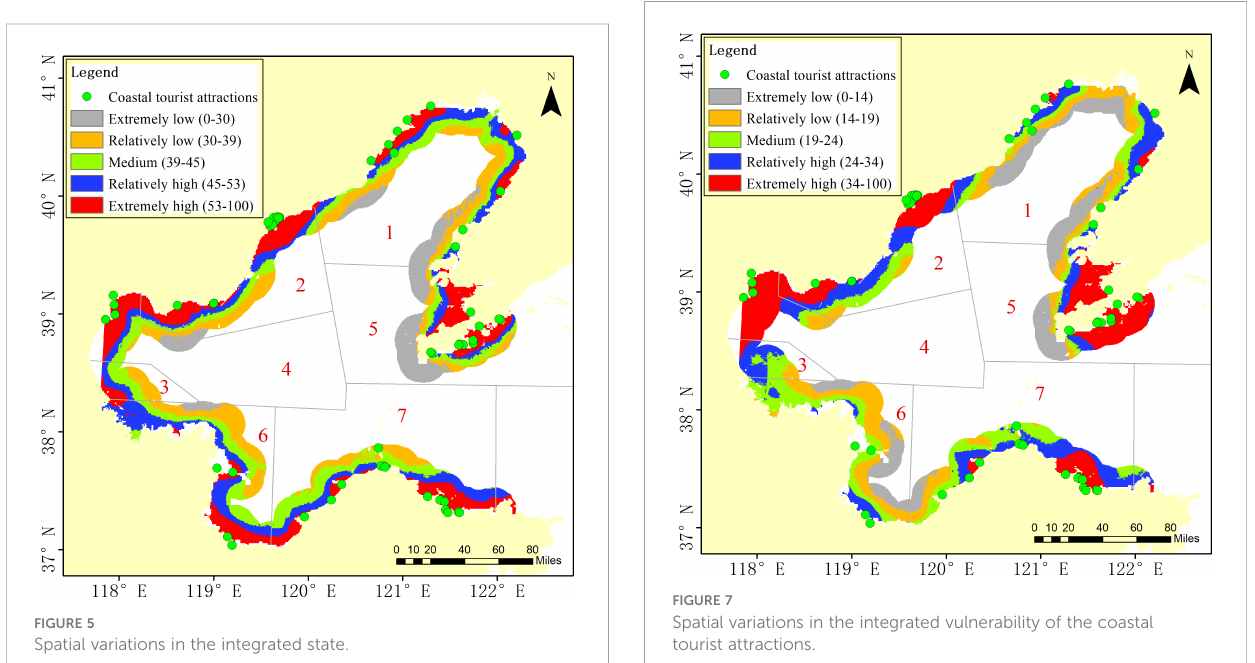
FIGURE 5 Spatial variations in the integrated state.